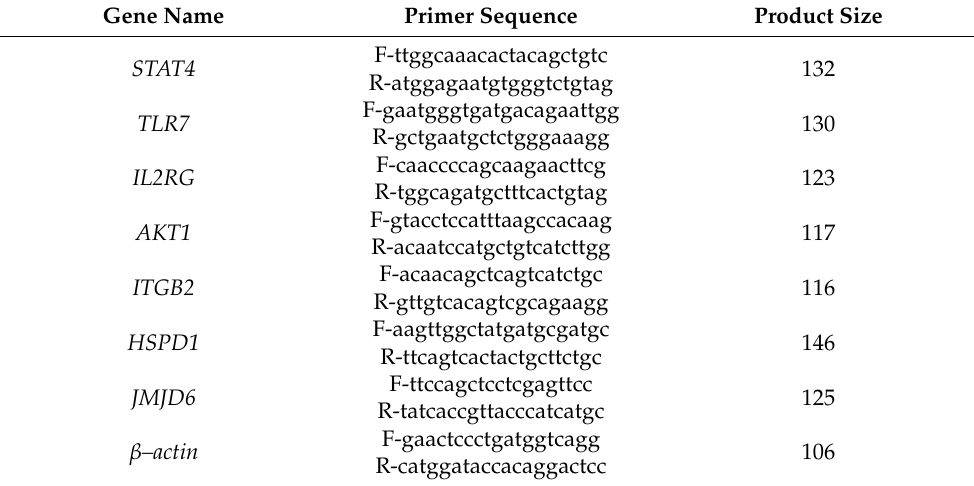
Table 1. List of primers used for RT-PCR assay.